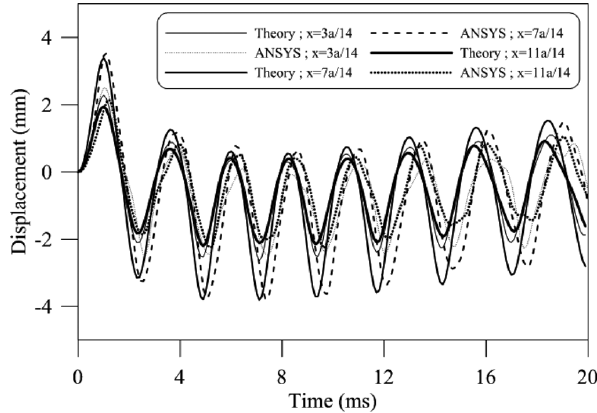
Fig. 19. The displacement-time histories of the simply-supported tapered laminated plates ( β = 1.2) for the stacking sequence [UCBGBC] S with [45/0/45] S .